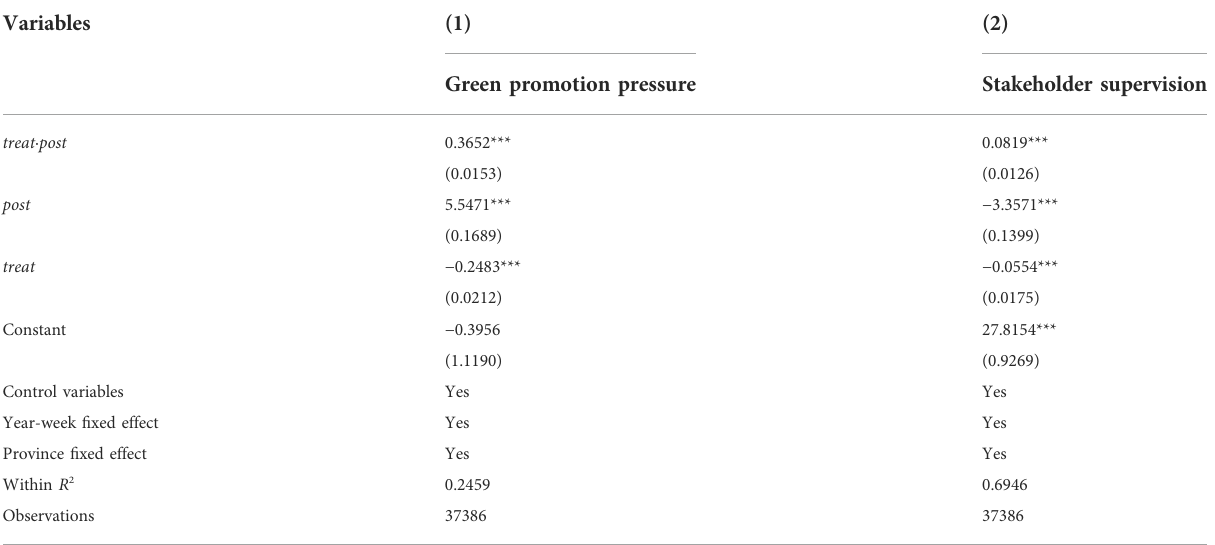
TABLE 5 Mechanism identi fi cation